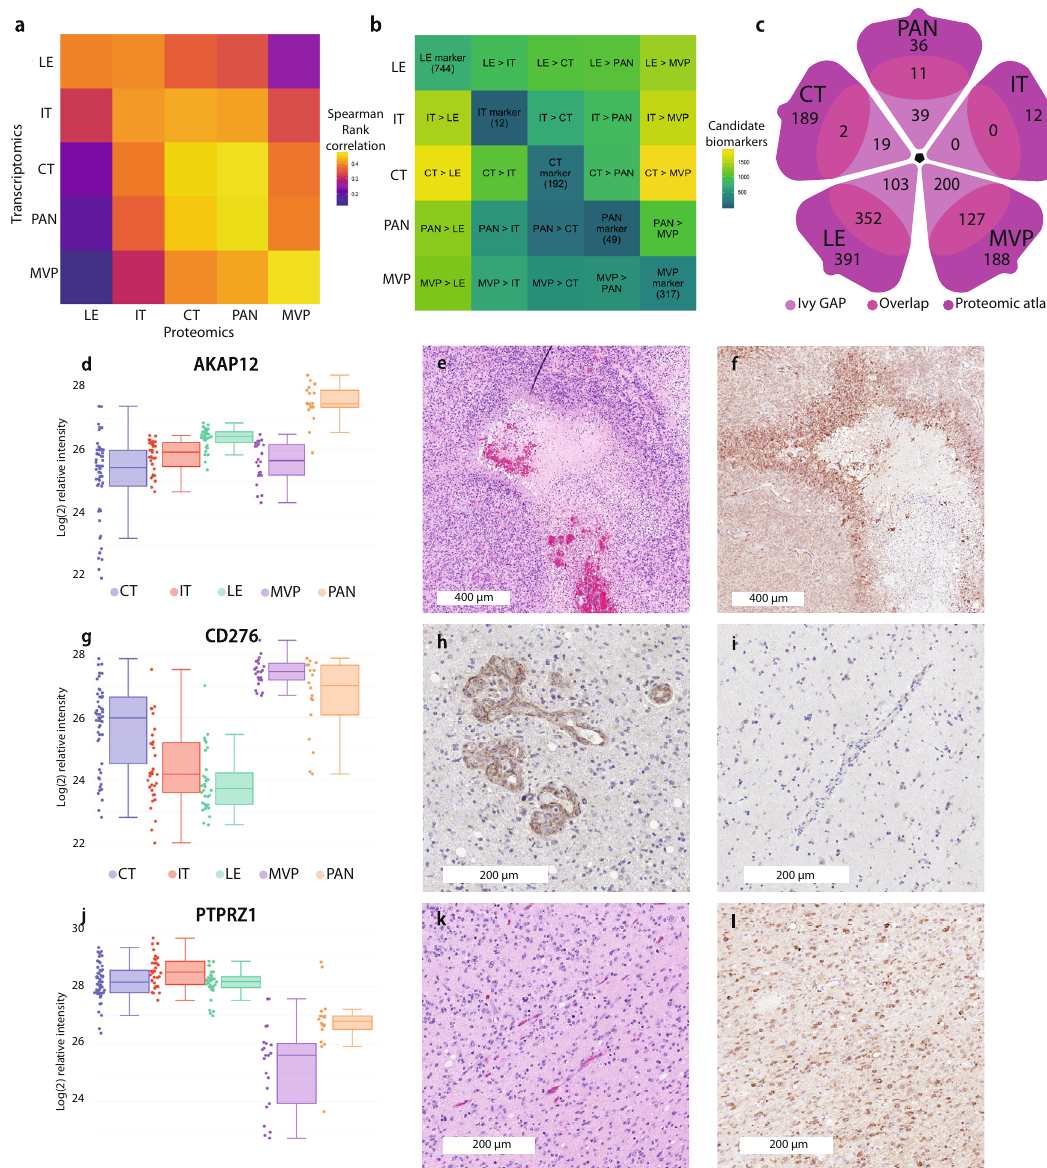
Fig. 3 Region-speci fi c biomarker identi fi cation and validation. a Spearman Rank correlation between histomorphological transcriptomic (Ivy GAP) and our own proteomic pro fi les, leading-edge (LE), in fi ltrating tumor (IT), cellular tumor (CT), palisading cells around necrosis (PAN), and microvascular proliferations (MVP). Only genes that were identi fi ed in both datasets were included in the analysis. b Differential expression matrix analysis based on genes identi fi ed based on all samples based on a two-sided t-test at p < 0.01 and 76 degrees of freedom. Values along the diagonal are the number of genes that are differentially abundant against all other regions. c Differential expression matrix comparison by Venn diagram across transcriptionally (Ivy GAP) and proteomically signi fi cant biomarkers. Only genes that were identi fi ed in both datasets were included. d Regional enrichment of AKAP12 by boxplot highlights increased expression within PAN ( n = 154). Data are presented as median values± IQR and min/max values (whiskers). e H&E image of GBM highlighting necrosis, PAN, and CT. f Region-speci fi c validation within an external cohort IHC demonstrates high staining of AKAP12 within PAN. g Regional enrichment of CD276 using boxplot highlights increased expression within MVP ( n = 154). Data are presented as median values ± IQR and min/max values (whiskers). Region-speci fi c validation within an external cohort by IHC demonstrates ( h ) high staining of CD276 within MVP but ( i ) no staining of vasculature in LE. j Regional enrichment of PTPRZ1 by boxplot highlights increased expression within IT ( n = 154). Data are presented as median values ± IQR and min/max values (whiskers). k H&E image of GBM highlighting LE and IT. l Region-speci fi c validation within an external cohort by IHC demonstrates high staining of PTPRZ1 within tumor cells of the IT. Source data are provided as a Source Data fi